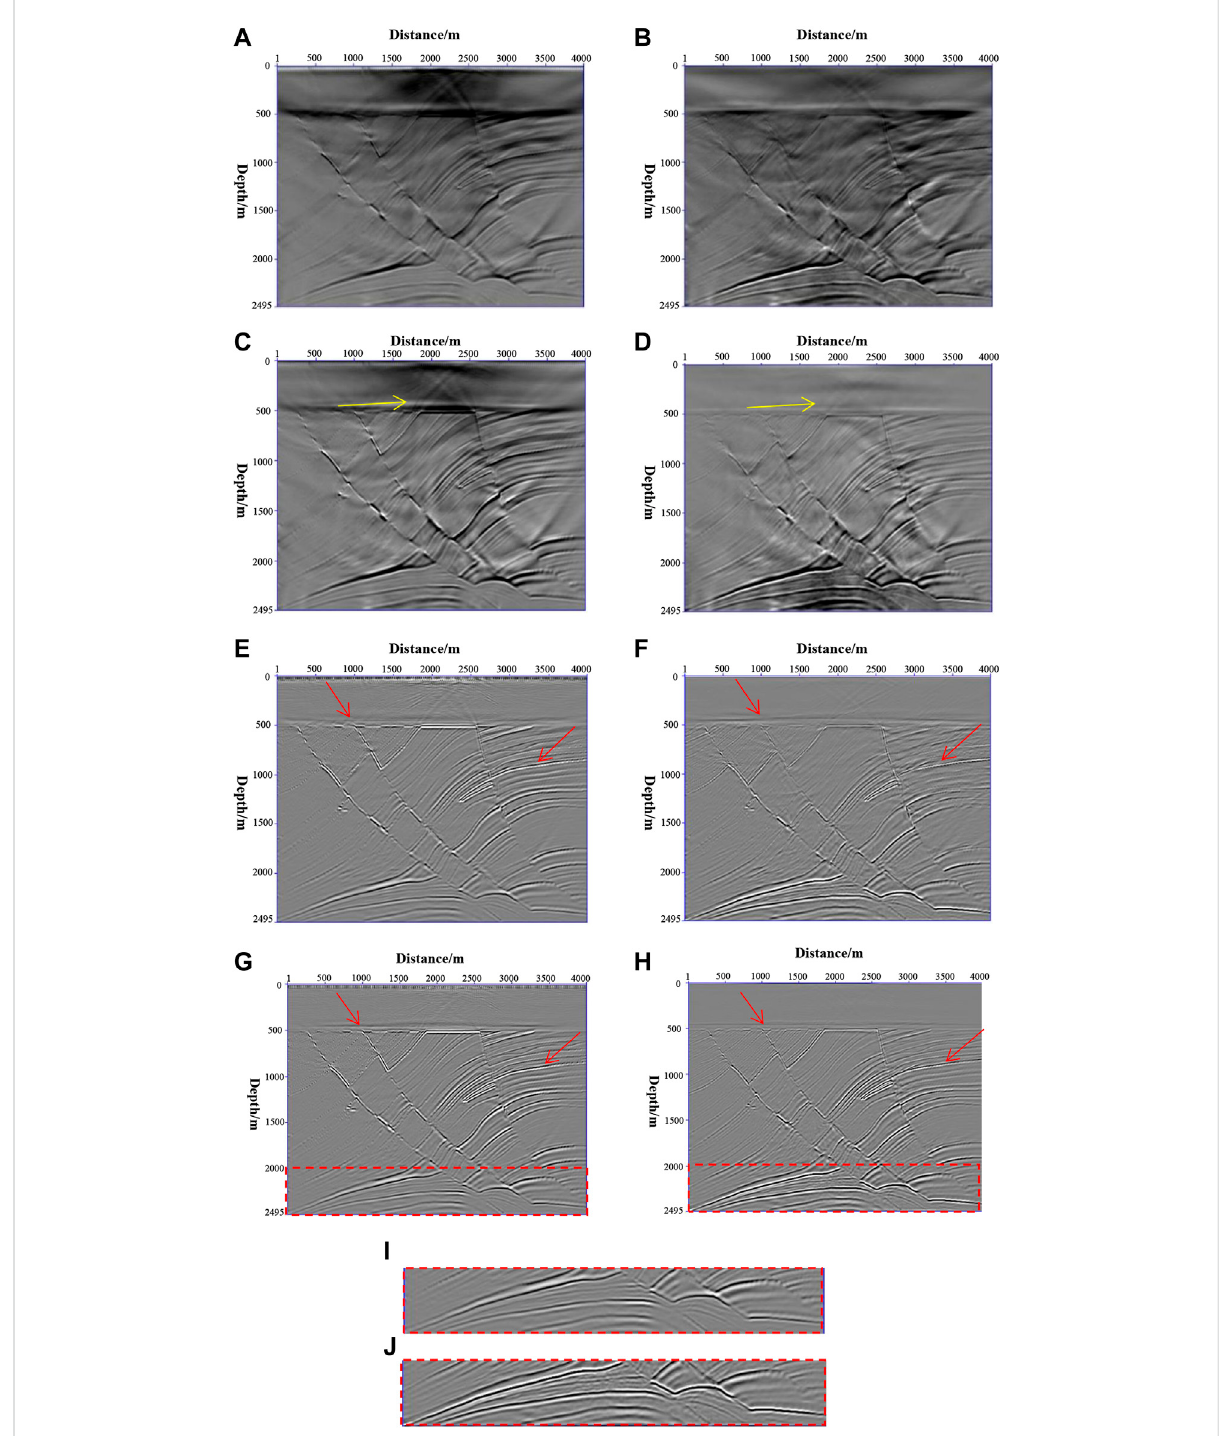
FIGURE 4 RTMandLSRTMoftheMarmousimodel. (A) RTMmigrationresults; (B) normalizedcross-correlationRTMmigrationresults; (C) resultsofcross- correlation conjugate gradient LSRTM with 15 iterations; (D) results of conjugate gradient normalized LSRTM with 15 iterations; (E) Laplace fi ltering resultsofFigure4 (A) ; (F) Laplace fi lteringresults ofFigure 4 (B) ; (G) Laplace fi lteringresults ofFigure4 (C) ; (H) Laplace fi lteringresultsofFigure4 (D) ; (I,J) are partial enlarged views of the red rectangular boxes in Figure 4 (G,H) ,